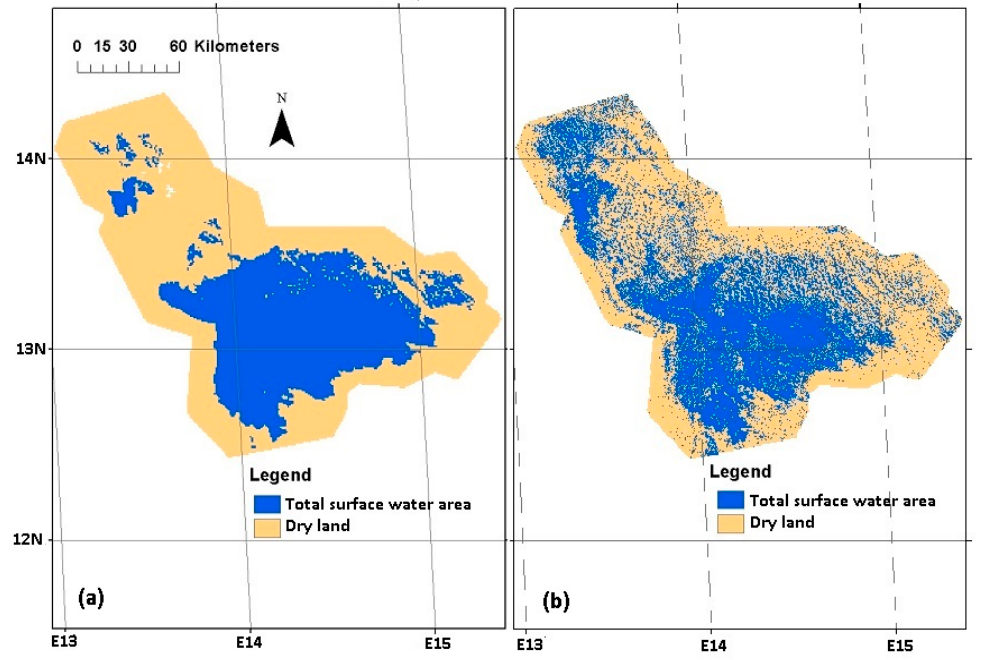
Figure 6. ( a ) Example NASA MODIS Land Surface Temperature (LST)-derived dry season water classification (31 October 2016–7 November 2016) ( b ) Example ESA Sentinel-1a C-band radar-derived dry season water classification (5 November2016).